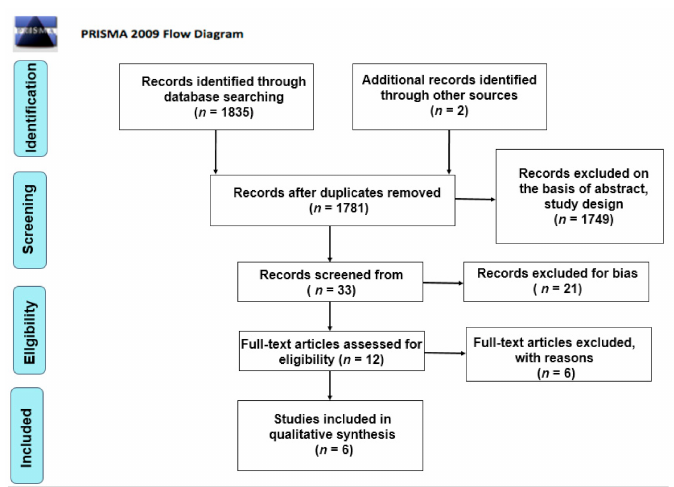
Figure 1. PRISMA flow